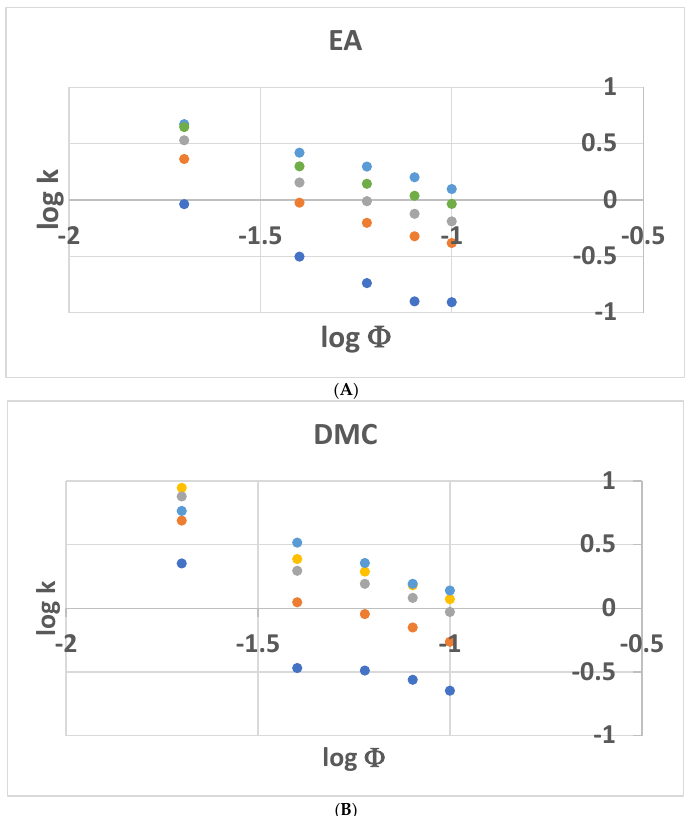
Figure 4. Log retention factor (k) versus log fraction ( Φ ) organic modifier. ( A ) Ethyl acetate (EA). ( B ) Dimethyl carbonate (DMC). Top to bottom between -1 and -1.5 for log Φ : dimethyl phthalate, diethyl phthalate, benzyl butyl phthalate, dibutyl phthalate, and dioctyl phthalate.